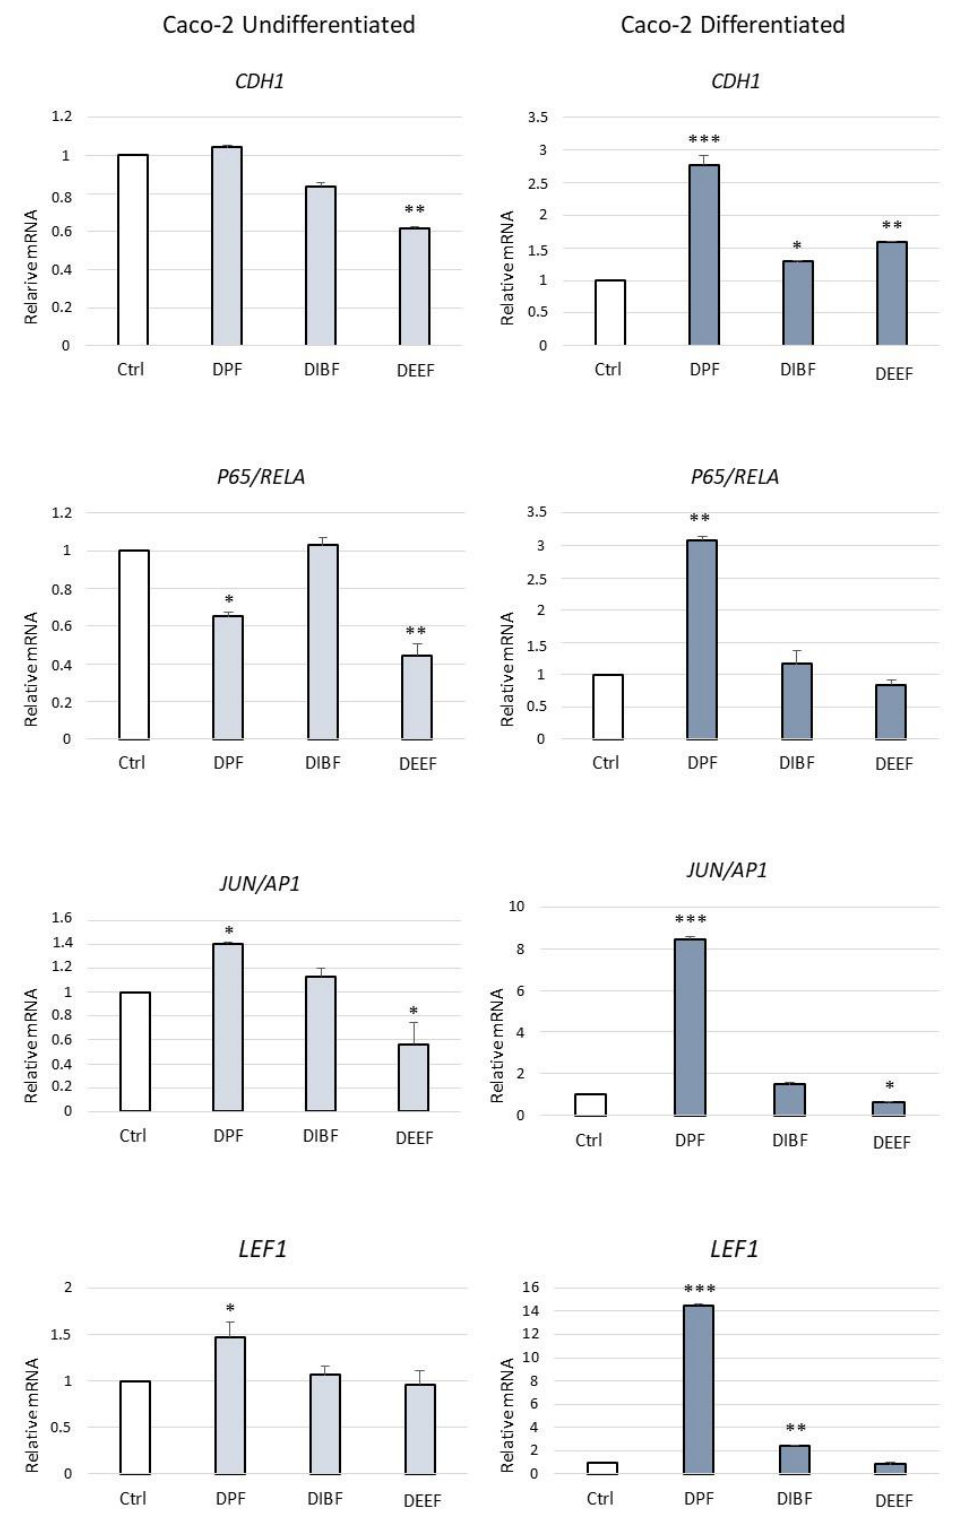
Figure 5. Gene expression modulation under PAE treatments in Caco-2 cells. Gene expression was analyzed by Real Time-qPCR. The histograms represented normalized data with GUSB gene. CDH1 (E-cadherin); P65/RELA (P65/RELA Proto-Oncogene NF-kB transcription factor subunit); JUN/AP1 (AP-1 transcription factor subunit of Jun Proto-Oncogene); LEF1 (Lymphoid Enhancer-Binding Factor 1). The histogram represented normalized data with GUSB gene. The results showed the average of three independent experiments. * p < 0.05, ** p < 0.01 and *** p < 0.001 treated vs. untreated